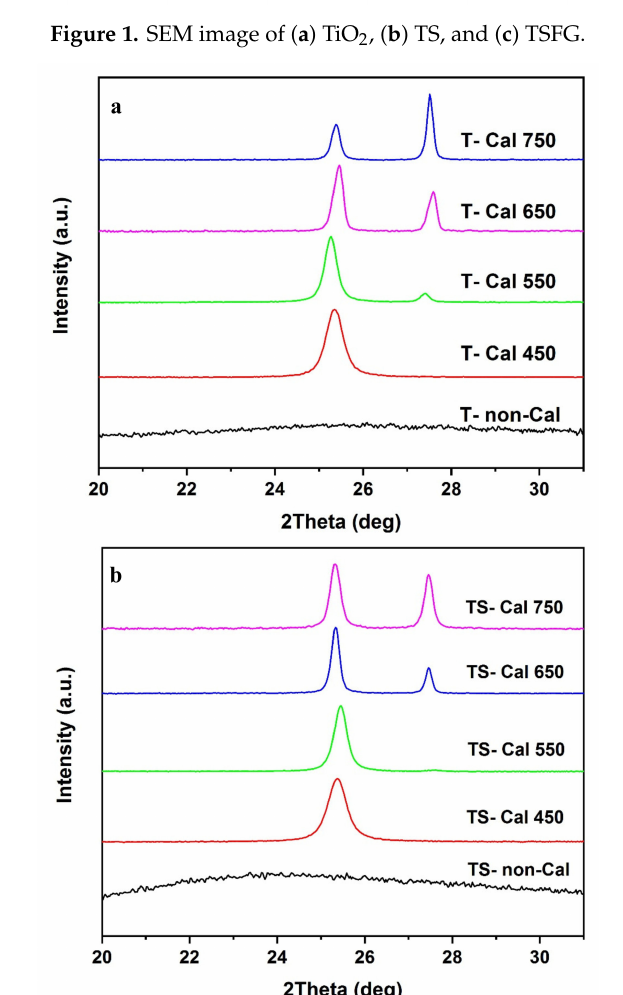
Figure 2. XRD patterns of ( a ) TiO 2 , and ( b ) TiO 2 / SiO 2 , after heat treatment at 450 ◦ C to 750 ◦ C for 120min in a